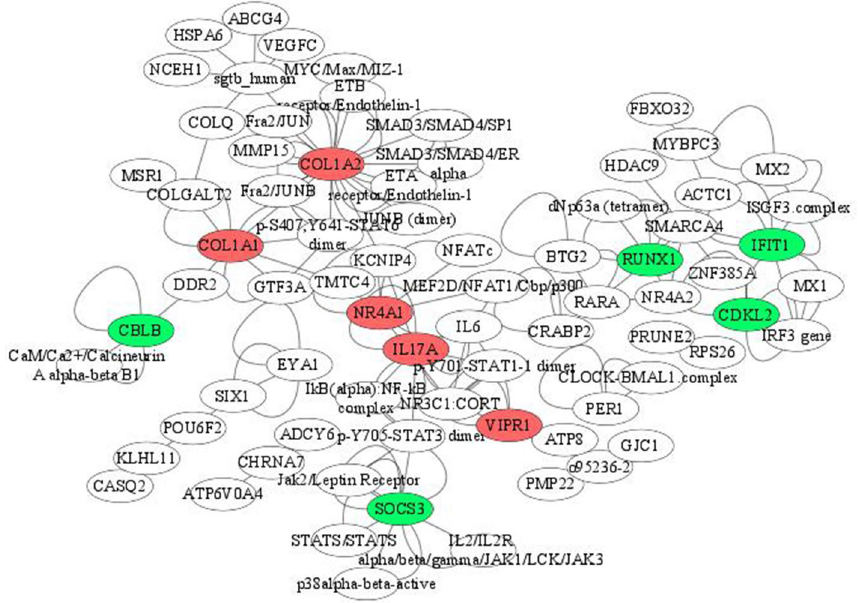
tooth stage or 1 years; Group 3 = 6 tooth stage or 2.5–3 years.